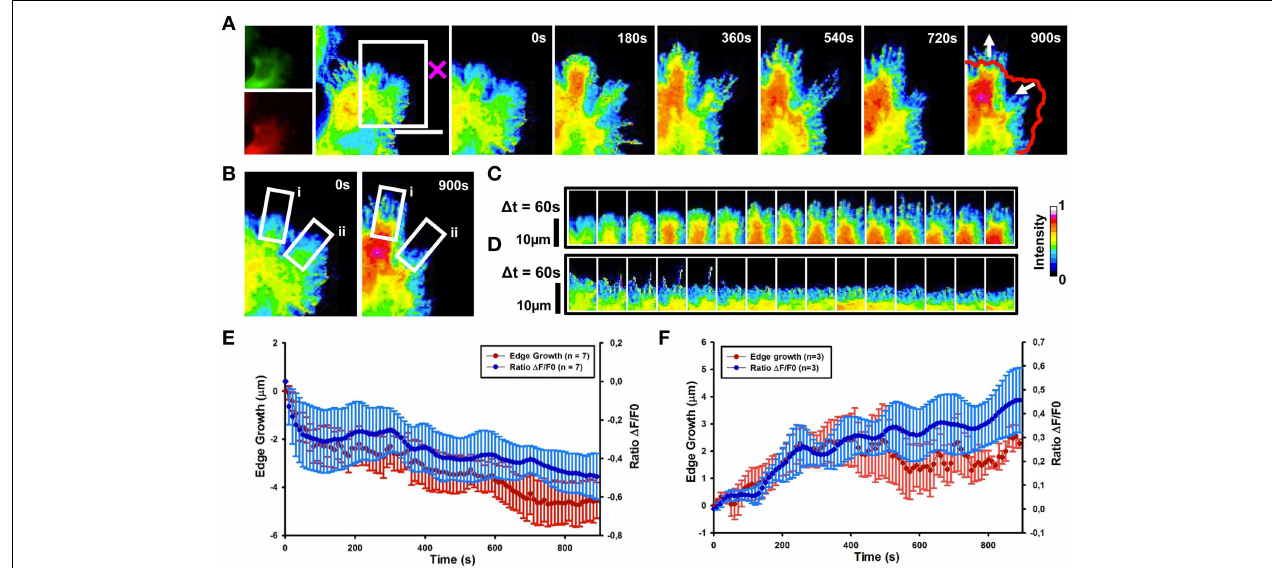
FIGURE 6 | Cdc42 dynamics upon local delivery of Sema3A. (A) Cdc42 activity determined by ratiometric FRET live imaging. Frames were taken every second (left: generation of a ratiometric image) for 15min after stimulation (the cross indicates the position of the lipid vesicle encapsulating Sema3A). Insets on the right show a time series (1 frame every 3min) of the magnified region denoted by the white box in the left image. Arrows indicate retraction and protrusion directions. The red line shows the initial edge profile. Scale Bar: 20 µ m. (B–D) Montage images showing the dynamics of Cdc42 activity in protruding and retracting regions of the cell. (B) Images showing the regions of interest selected for the montage (white boxes)